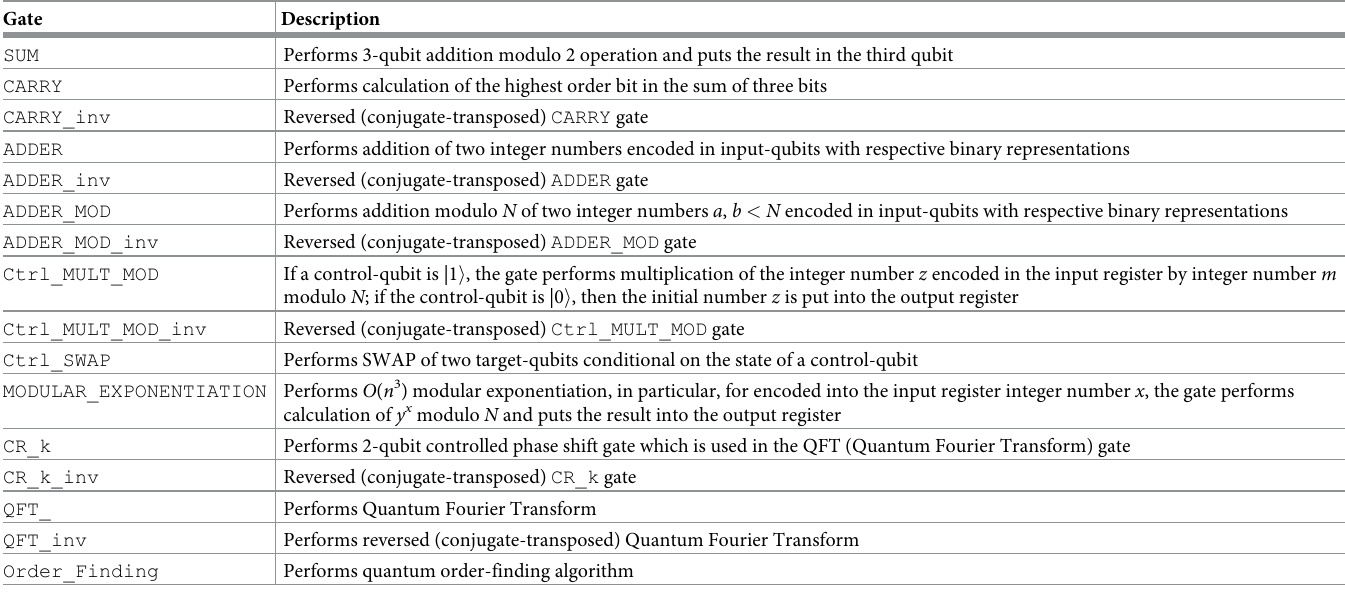
Table 1. PennyLane’s templates developed for realization of quantum gates.